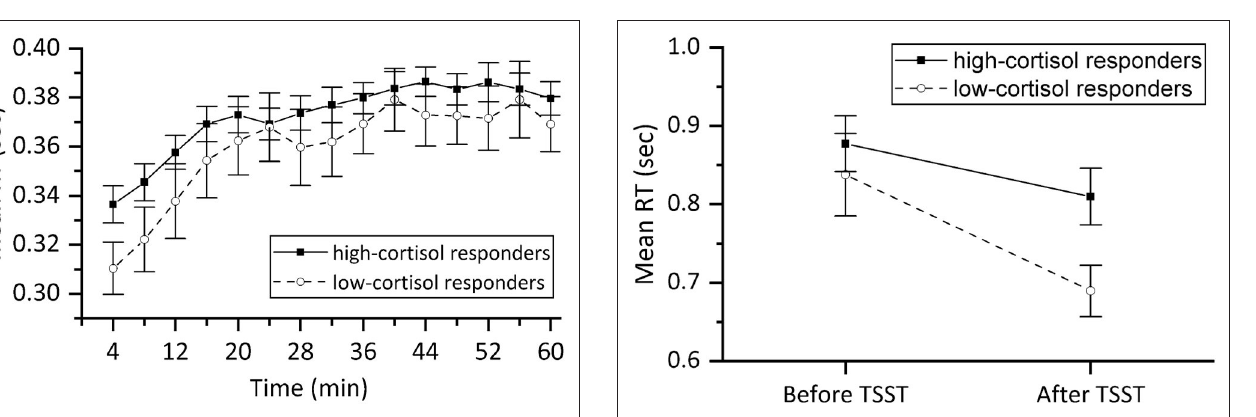
FIGURE 9 | Mean reaction time (sec) of valid responses in the NBACK session before and after the TSST for high-cortisol responders ( n = 28) and low-cortisol responders ( n = 9). Error bars represent ±